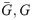
Comparative Effectiveness of the Updating-sample Strategy (Acq(G¯,G)) Versus the Strategy with Access to Complete Census (Acq(G, G)).Examined in terms of the difference in their outbreak size (both measured in percent of network infected). This comparison is assessed at the highest level of missing data, over a range of β to see how this comparative effectiveness varies with the regime of transmission probability. The immunization level for all tests shown here is 10%. In panel (A), the measured value of R0 ranged from 1.40 to 3.84. In panel (B), the measured values for R0 ranged from 2.91 to 5.15. In panel (C), the measured values for R0 ranged from 3.49 to 7.79. In panel (D), the measured values for R0 ranged from 2.81 to 4.95.